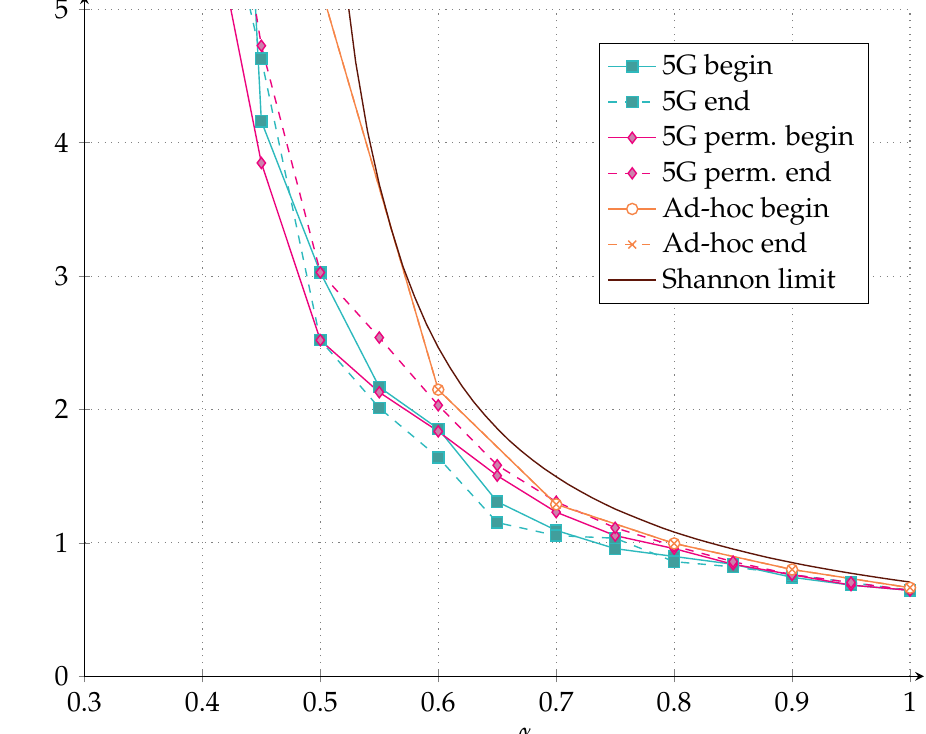
Figure 6. Maximum interference power versus α for different protographs and outage capacity on a QPSK channel with fixed AWGN at E s / N 0 = 6 dB. The 5G corresponds to the ensemble with base matrix B 5G . The 5G perm.corresponds to the ensemble with base matrix B π the ensemble with base matrix B A . Begin and end represent the iterative decoding threshold with the interference hitting the codeword from the left or the right,